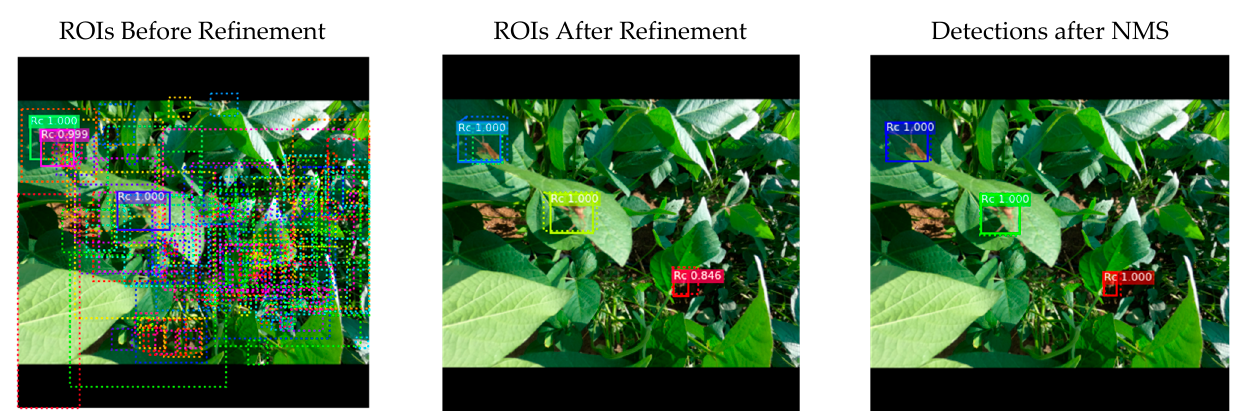
Figure 2. Region of interest (ROI) pooling process. Artificial intelligence identifies many region proposals that were classified as a result of a convolutional neural network. The region proposal goes through a max-pooling process during the refinement stage of object detection. Through ROI pooling, the confidence and region of the bounding box are being accurate, and the network builds features of a fixed size.